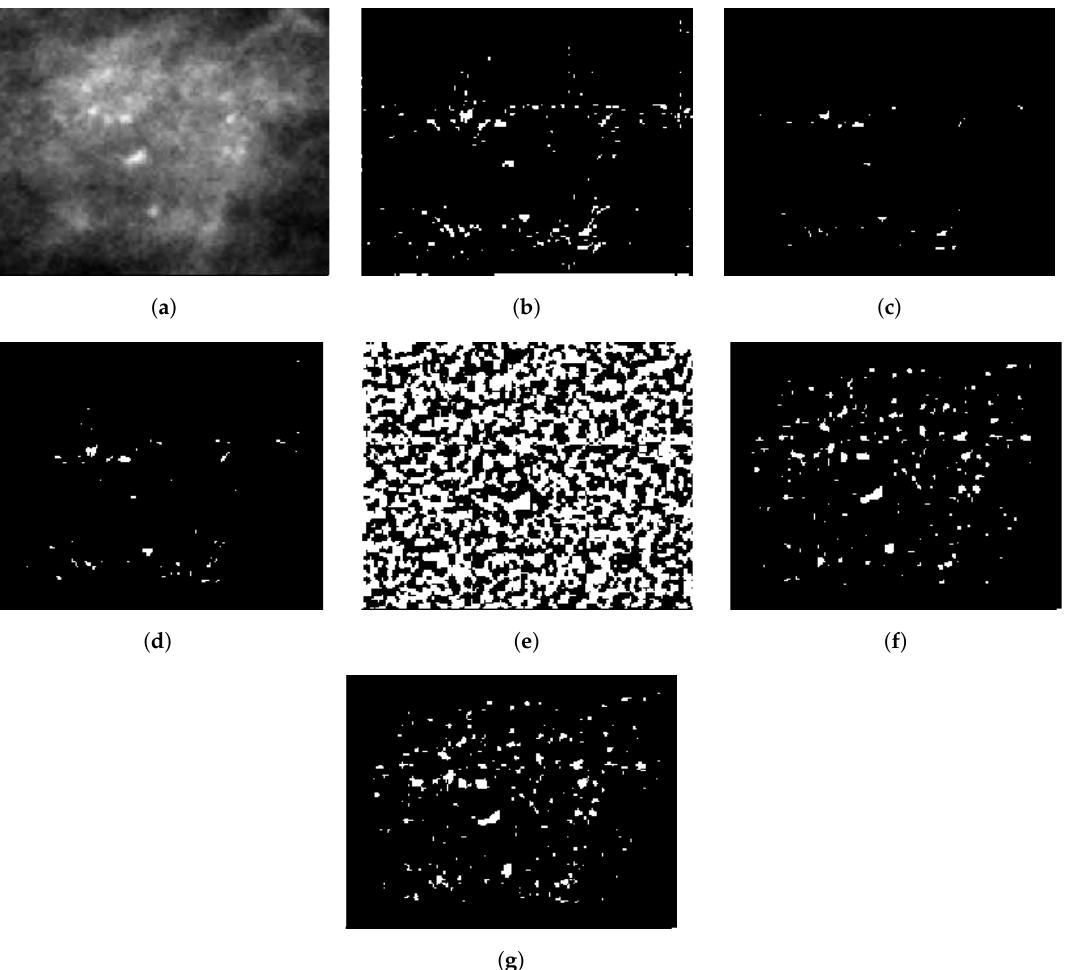
Figure 5. ( a ) Enhanced image patch ( 1_1076_463 ) from the OMI-DB database; ( b ) binary image containing 5% of the highest positive intensity values from the difference image; ( c ) eliminating single pixels and perform erosion on ( b ); ( d ) Image A: pixels having higher value than the specified threshold mention in Section 2.2.2 are added to ( c ); ( e ) contrast enhancement filter applied to the bi-cubic interpolated image of ( a ); ( f ) Image B: five percent of the pixels having the highest intensity are selected from the filtered image; and ( g ) Image C: Logical summation of ( d ) and ( f